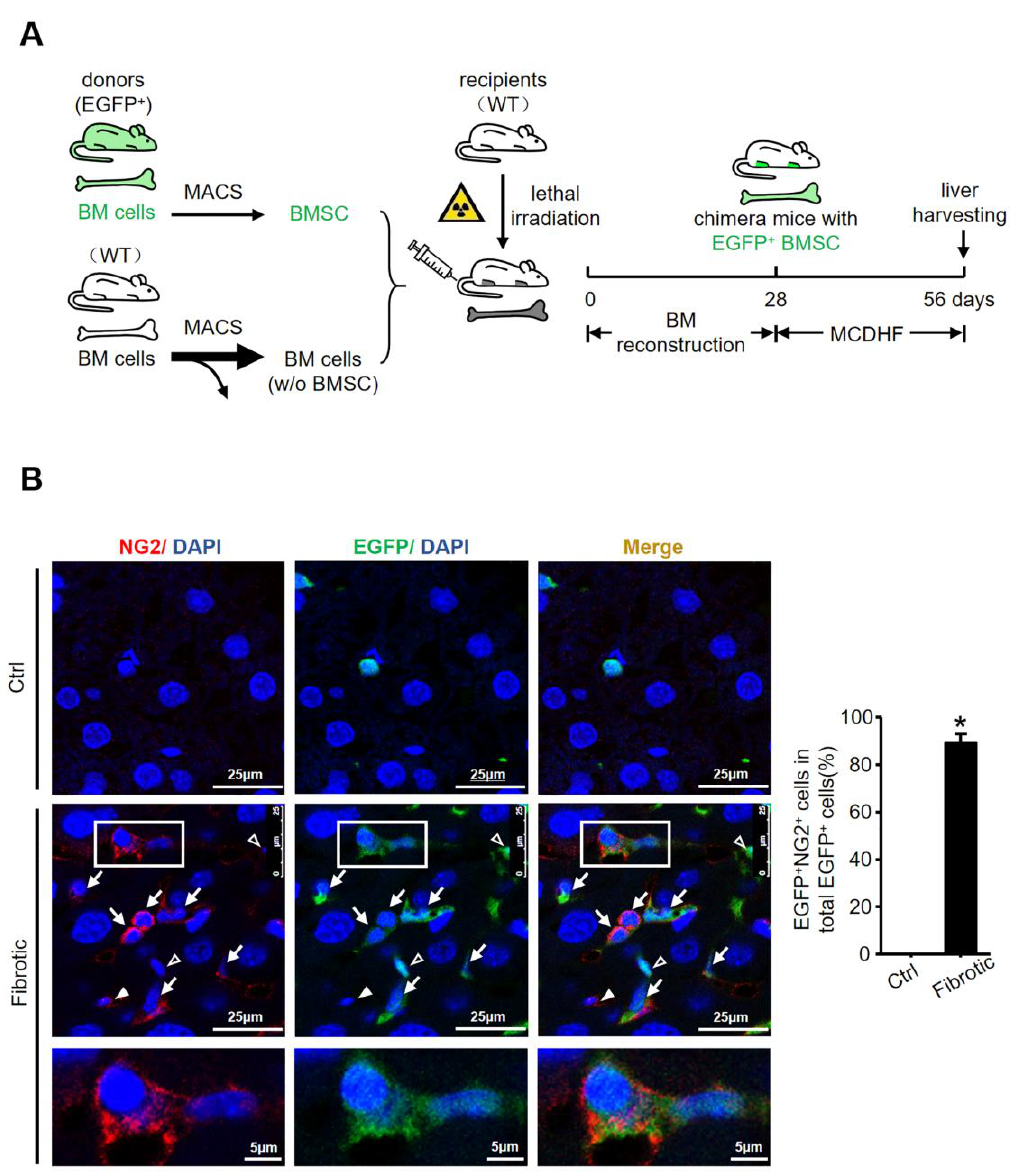
Figure 3. The high expression of NG2 on BMSC-derived MF in fibrotic liver. ( A ) Schematic images of the strategy for generating chimera mice with EGFP + BMSC, followed by MCDHF-induced liver fibrosis. ( B ) Representative images of NG2 (red), EGFP (green) and merged fields from immunofluo- rescence analysis to visualize NG2 expression in BMSC-derived MF in the fibrotic liver. Pictures in the third row are taken from the fields that are indicated as “ white box ” in the second row. Hollow arrows indicate NG2 − EGFP + cells (cells expressing EGFP but not NG2), solid arrows indicate NG2 + EGFP − cells (cells expressing NG2 but not EGFP), and arrows indicate NG2 + EGFP + cells. DAPI (blue) was used to visualize nuclei. The proportion of NG2 + EGFP + cells accounting for total EGFP + cells was measured by Image-Pro Plus software. Data are presented as the mean ± SEM. * p < 0.05 vs. control.